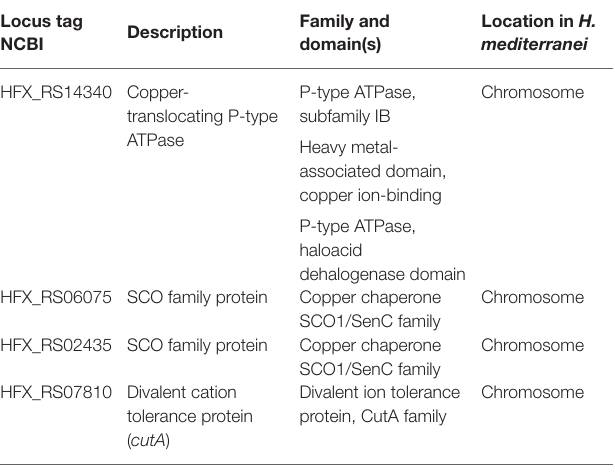
TABLE 2 | Genes coding for copper metallochaperones in Haloferax mediterranei genome. Locus tag